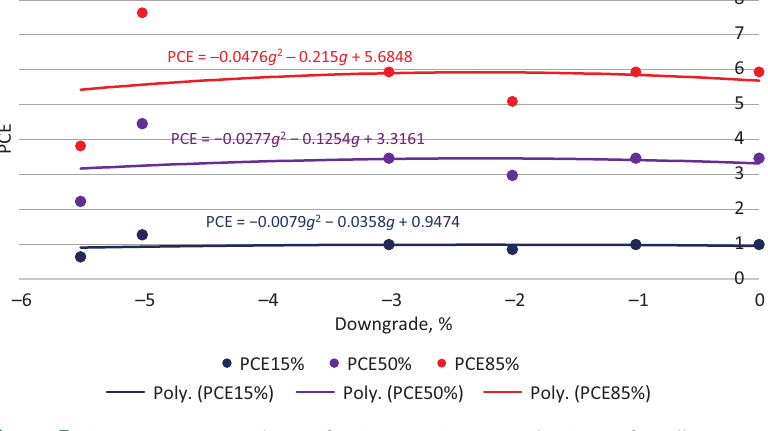
15% , PCE 50% and PCE 85% for all